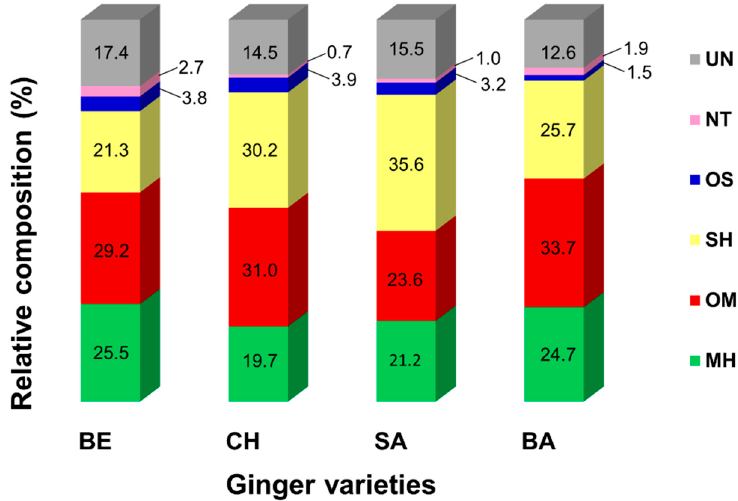
Figure 1. Relative metabolic composition (%) of the analyzed Z. officinale essential oils: Bentong (BE), Cameron Highlands (CH), Sabah (SA), and Bara (BA). The constituents consist of: monoterpenic hydrocarbons (MH), oxygenated monoterpenes (OM), sesquiterpenic hydrocarbons (SH), oxygenated sesquiterpenes (OS), non-terpenic compounds (NT), and unidentified compounds (UN). The sesquiterpenic profile revealed a major contribution of its sesquiterpenes ana- logues, with SA oil having the highest relative amount (35.6%). The major sesquiterpenes were α -curcumene (2.2–4.5%), zingiberene (7.9–14.0%), β -bisabolene (4.6–8.4%), and β - sesquiphellandrene (3.2–5.2%) for all samples. The concentration of zingiberene was much lower in BE (7.9%) than the other varieties (12.1%, 14.0%, and 10.8% for CH, SA,